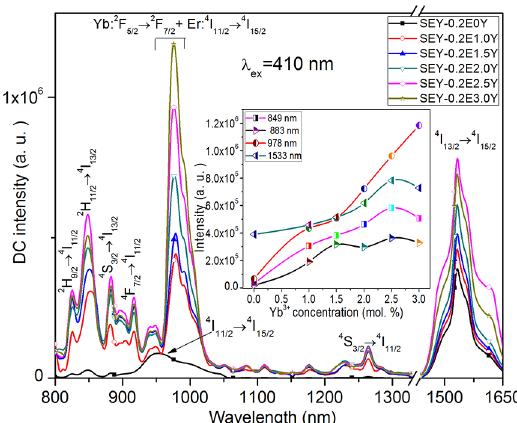
Figure 7. DC emission spectra of SEY-0.2E0Y, SEY-0.2E1.0Y, SEY-0.2E1.5Y, SEY-0.2E2.0Y, SEY-0.2E2.5Y and SEY-0.2E3.0Y transparent glass-ceramics samples.